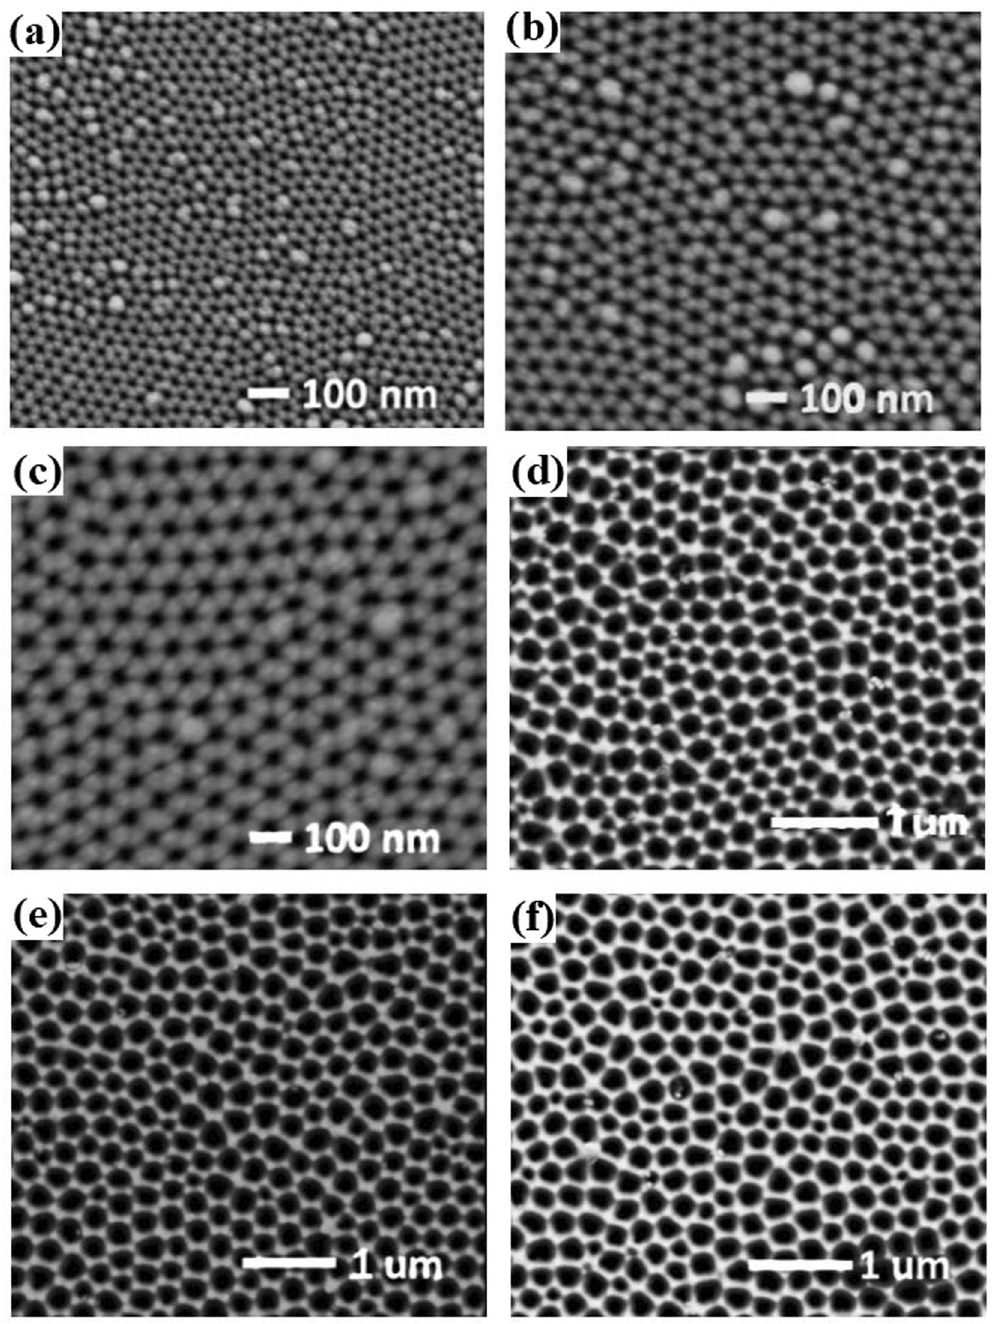
Figure 1. Top-viewed SEM images of multi-layered nanoporous arrayed films deposited on six AAO templates with different geometries ( a ) S = 110 nm, D = 40 nm, ( b ) S = 110 nm, D = 60 nm, ( c ) S = 110 nm, D = 100 nm, ( d ) S = 450 nm, D = 130 nm, ( e ) S = 450 nm, D = 160 nm and ( f ) S = 450 nm, D = 200